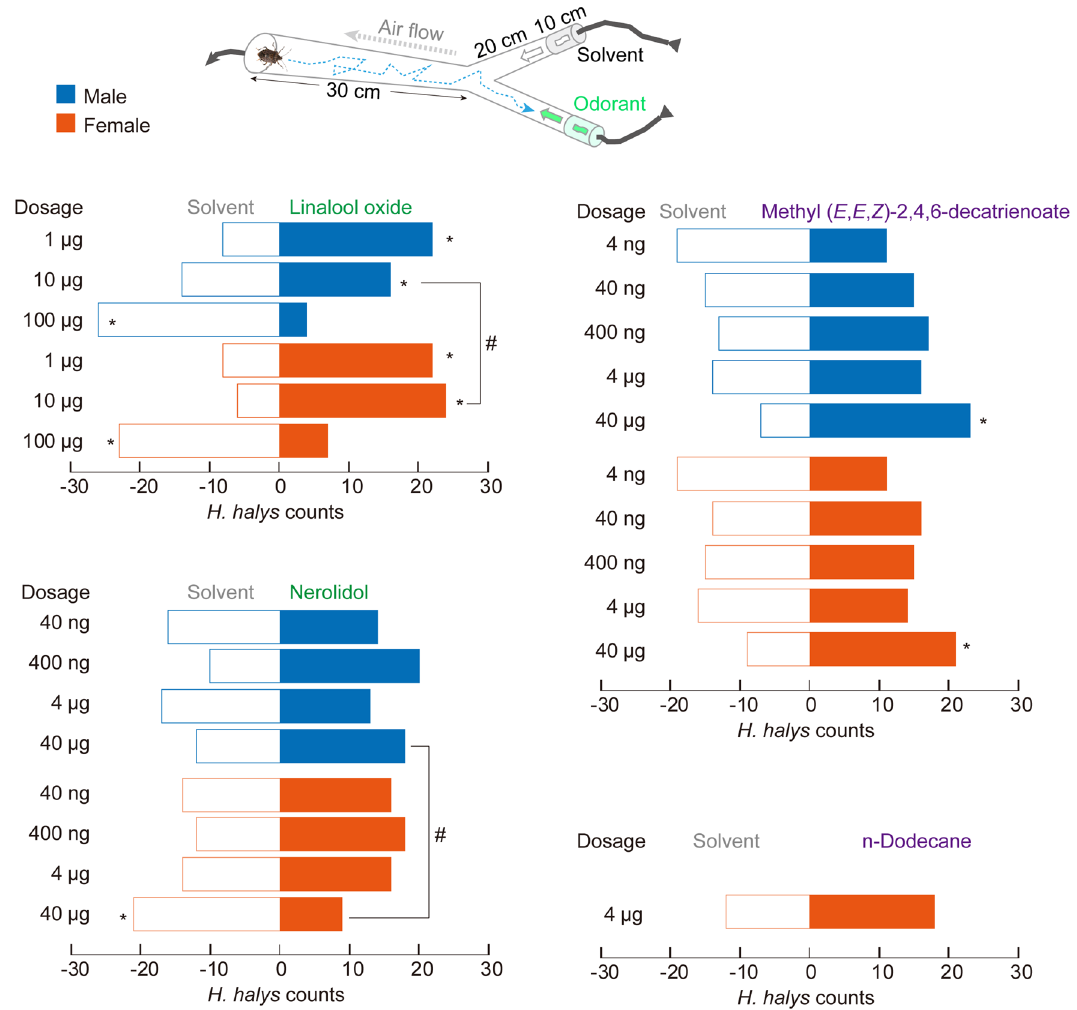
Figure 1. Behavioral valence of H. halys to various tested volatiles. Results of Y-tube assays with H. halys by applied selected botanical and pheromone-related chemicals. Asterisk indicates significant choice preferences of H. halys to either tested chemicals or solvent control ( Chi -square test, P < 0.05, n = 30 for each gender at each dosage toward each treatment). Hashtag indicates significant choice preferences between genders to the same dosage treatment ( Chi -square test, P = 0.0285 for linalool oxide at 10 μg and P = 0.0195 for nerolidol at 40